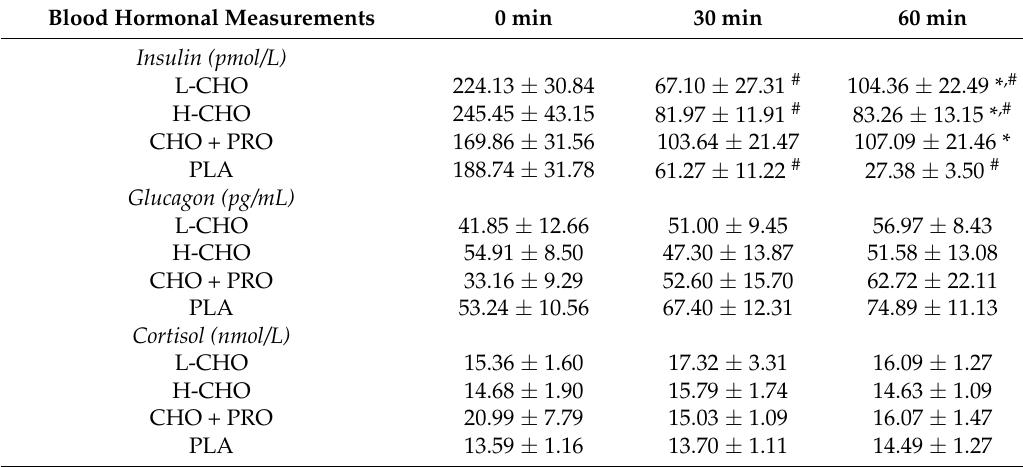
Table 4. Blood hormonal change during exercise following treatments.